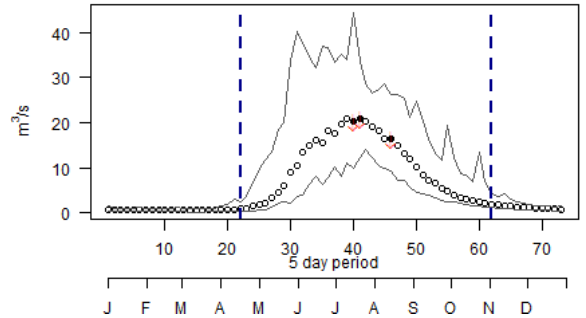
Figure 9. Example of the trend portion of the summary hydrograph: the two dashed lines indicate the start and end of the common win- dow from period 23 to period